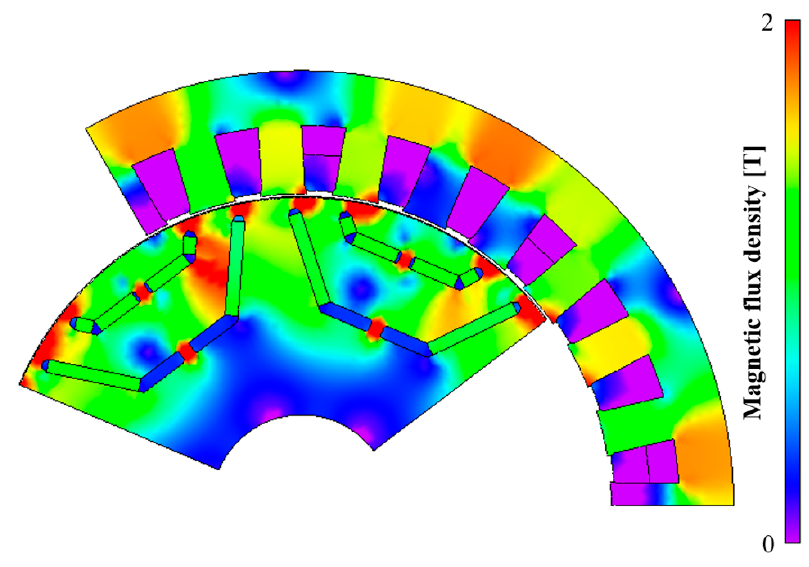
Figure 12. Magnetic flux density of the optimum model.